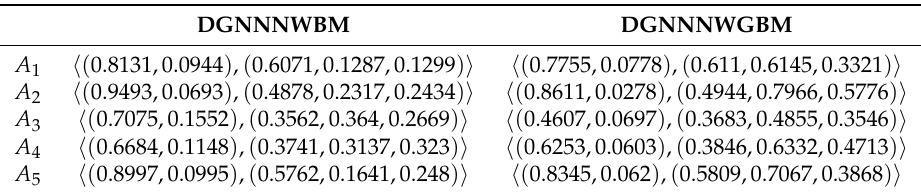
Table 13. The DGNNNWBM operator and DGNNNWGBM operator R = ( 14,15,1,1 ) . DGNNNWBM